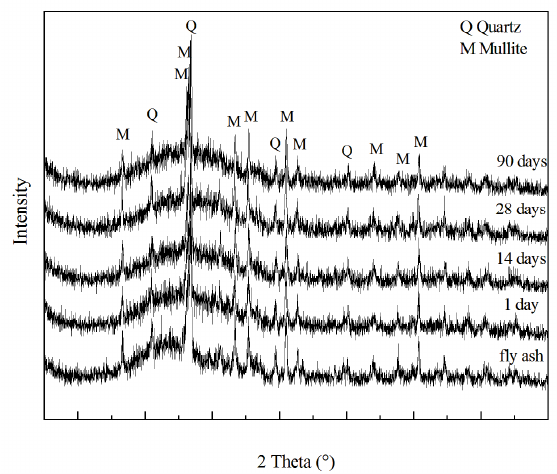
Figure 11. X-ray di ff raction (XRD) patterns of fly ash and GLWC samples after curing for 1, 14, 28, Figure 11. X-ray diffraction (XRD) patterns of fly ash and GLWC samples after curing for 1, 14, 28, and 90 and 90 days.